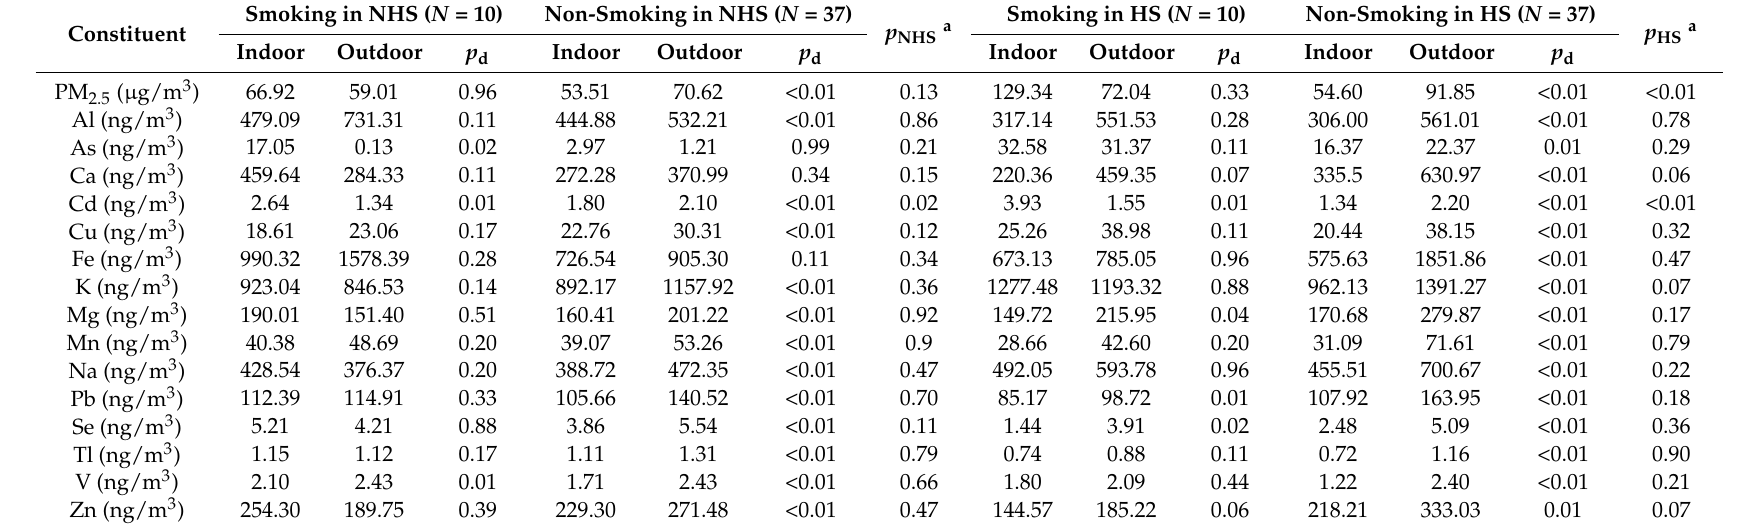
Table 3. Comparison of indoor and outdoor concentrations of PM 2.5 and elements in smoking and non-smoking houses